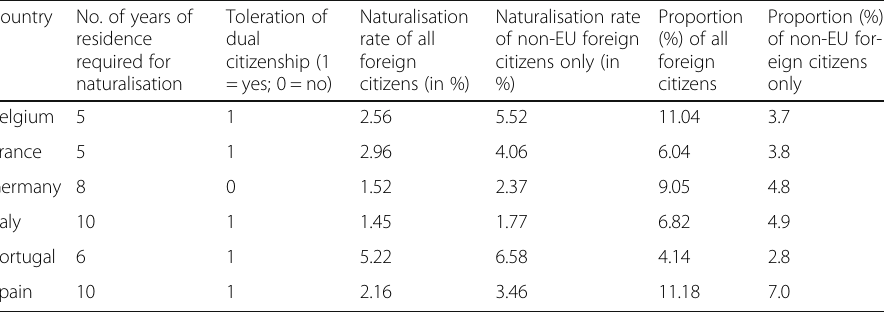
Table 4 Measures of national citizenship policies in the six selected countries in 2011 Country No. of years of